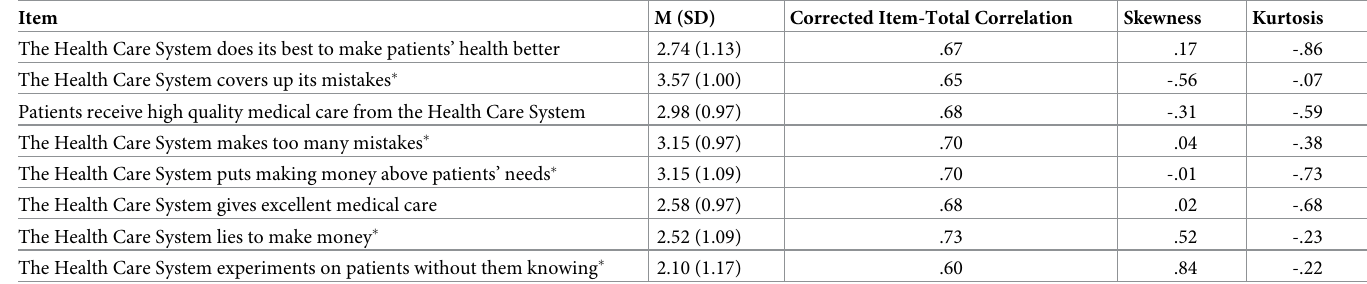
Table 3. Descriptive statistics for the trust in healthcare system scale.